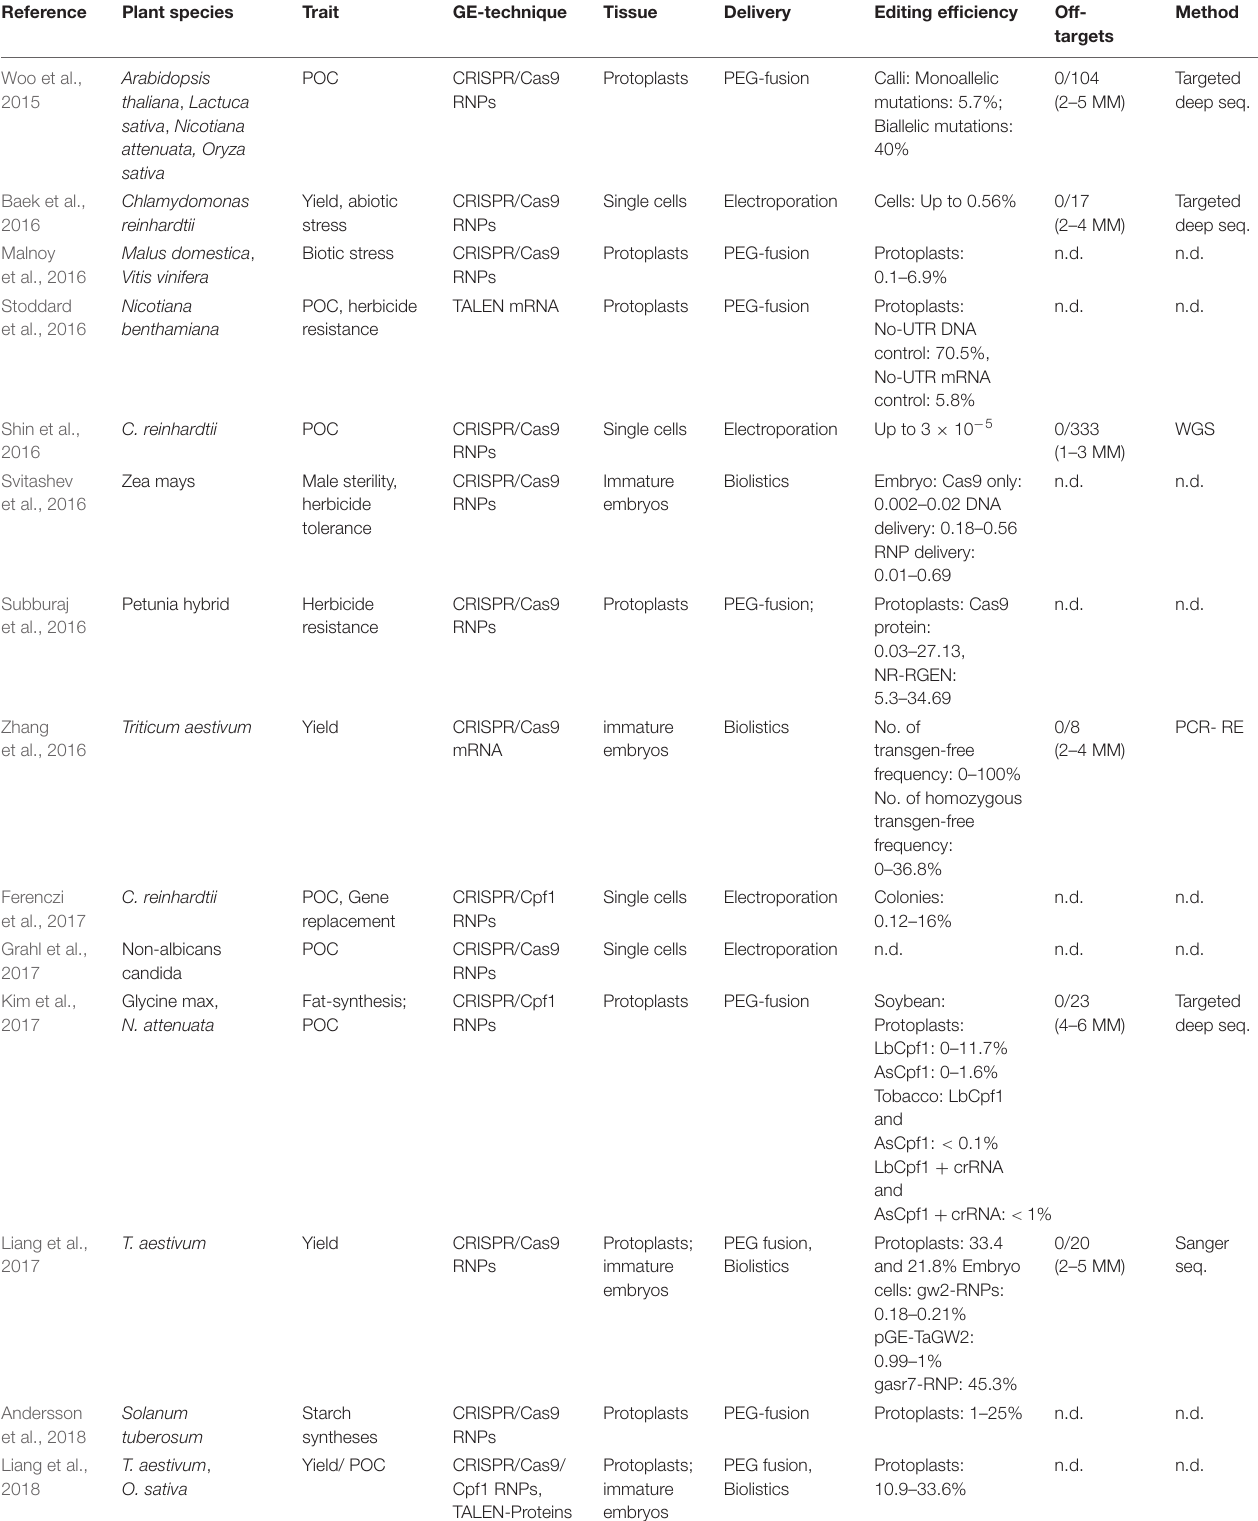
TABLE 1 | Recent publications using DNA-free Genome Editing